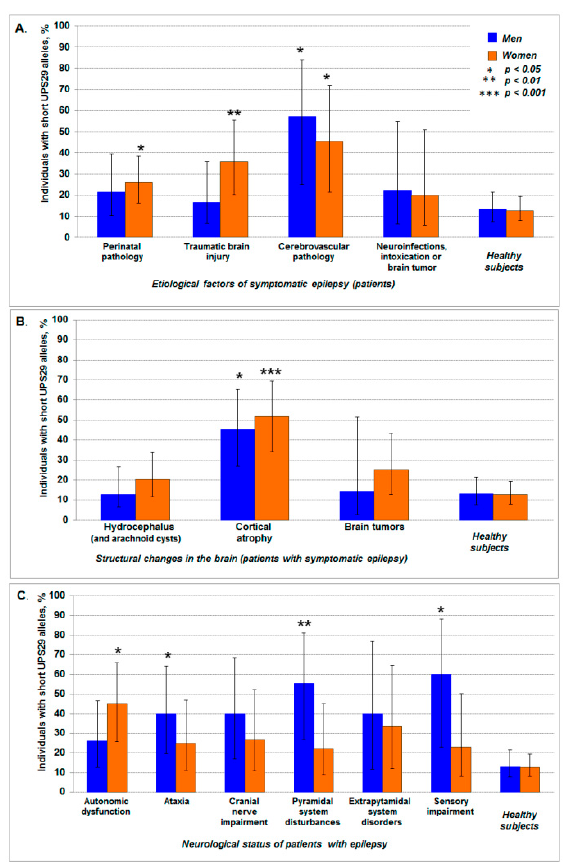
Figure 2. The frequency of carriers of short UPS29 alleles among patients with epilepsy of different etiology ( A ), structural changes in the brain ( B ), and neurological status ( C ). The data is shown with 95% CI. The asterisk indicates statistically significant differences in comparison with control (healthy subjects).